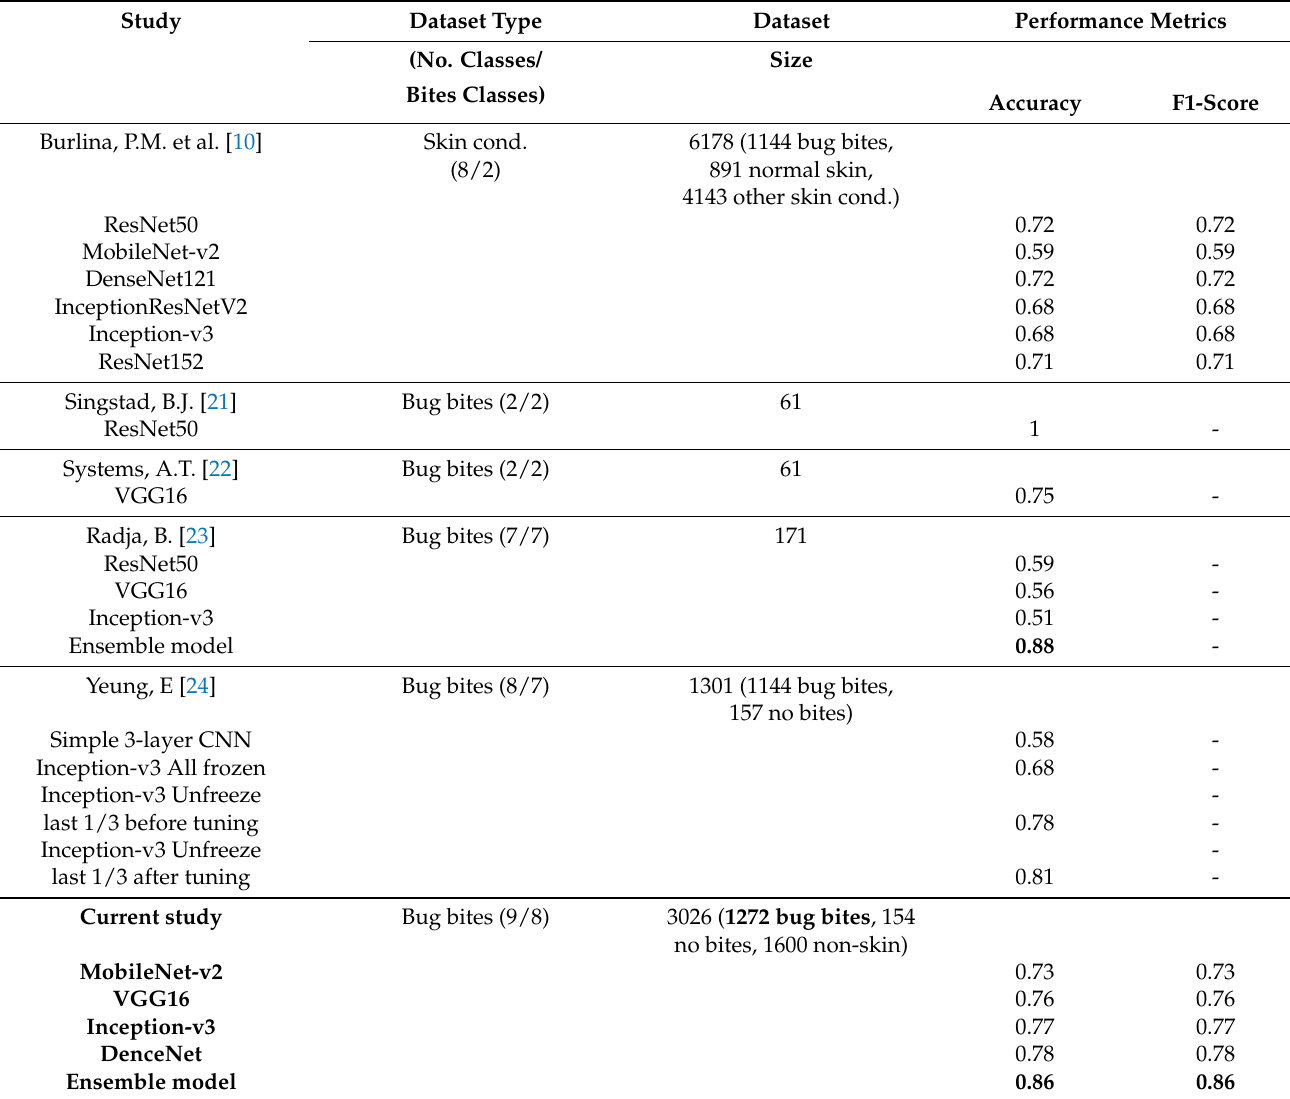
Table 16. Performance comparison of the proposed ensemble scheme individual CNN models examined in this research (MobileNet-v2, VGG16, Inception-v3, and DenseNet169) with the related